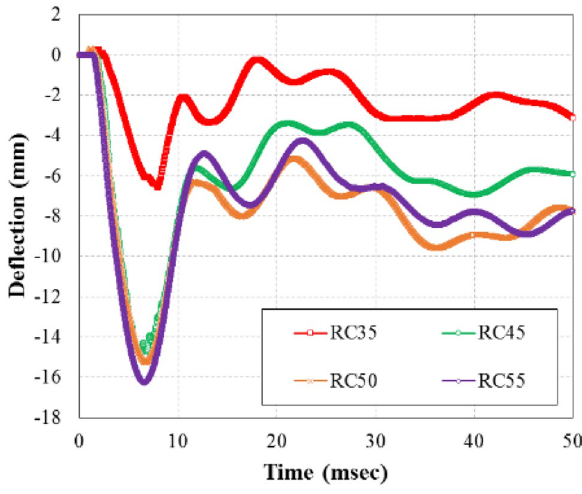
Figure 9. Time-deflection curves of